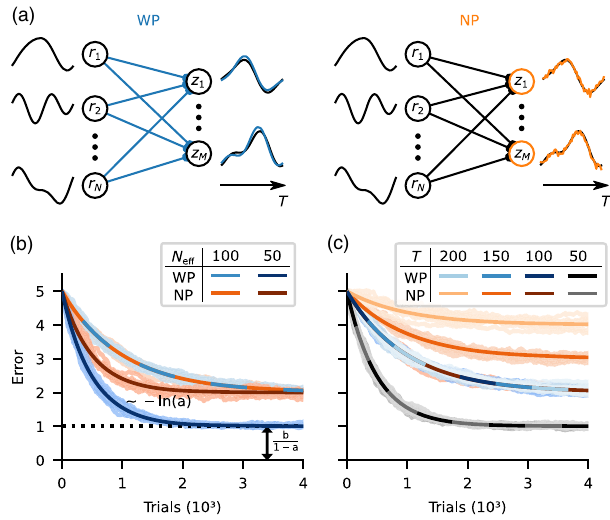
FIG. 1. Learning of temporally extended tasks in linear net- works. (a) Schematic setup of WP and NP. The M outputs z are i weighted sums of the N inputs r . Left: WP perturbs the weights j at the beginning of a trial; the resulting perturbations of the weighted sums of the inputs and, thus, the outputs reflect the dimensionality and smoothness of the inputs (blue). Right: NP perturbs the weighted sums of the inputs with dynamical noise (orange). (b) WP (blue) works just as well as or better than NP (orange) when learning a single temporally extended input-output mapping. The error decay time decreases for WP and NP likewise with decreasing effective input dimension N (light versus dark eff curves). In contrast, the residual error decreases only for WP. (c) Increased trial duration T does not change the progress of WP learning (blue curves lie on top of each other). In contrast, increasing T hinders NP learning by increasing the residual error (compare the increasingly lighter orange curves for larger T ). If T decreases N (gray curves), convergence is faster and to a lower eff residual error in both WP (because of the decrease in N ) and eff NP (because of the decrease in N and T ). (b) shows error curves eff from simulations (ten runs, shaded) together with analytical curves for the decay of the expected error (solid), for fixed ∈ f 100 ; 50 g ; σ 0 . 04 . Theo- T; N ¼ 100 , M ¼ 10 , and N eff eff ¼ 50 , retical curves and simulations agree well. For WP and N eff ¼ the decay rate [ − ln ð a Þ ] and the residual error (dashed line) are highlighted. (c) shows error curves from simulations and theory similar to (b) for fixed N ¼ 100 and T ∈ f 200 ; 150 ; 100 ; 50 g . N is set to 100 but cannot be greater than T , such that T ¼ 50 eff 50 forces N eff ¼